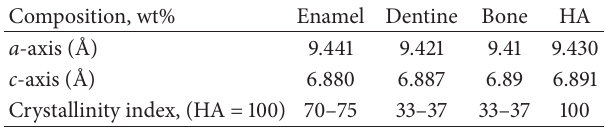
Table 2: Crystallographic properties: lattice parameters ( ± 0.003 ˚A).